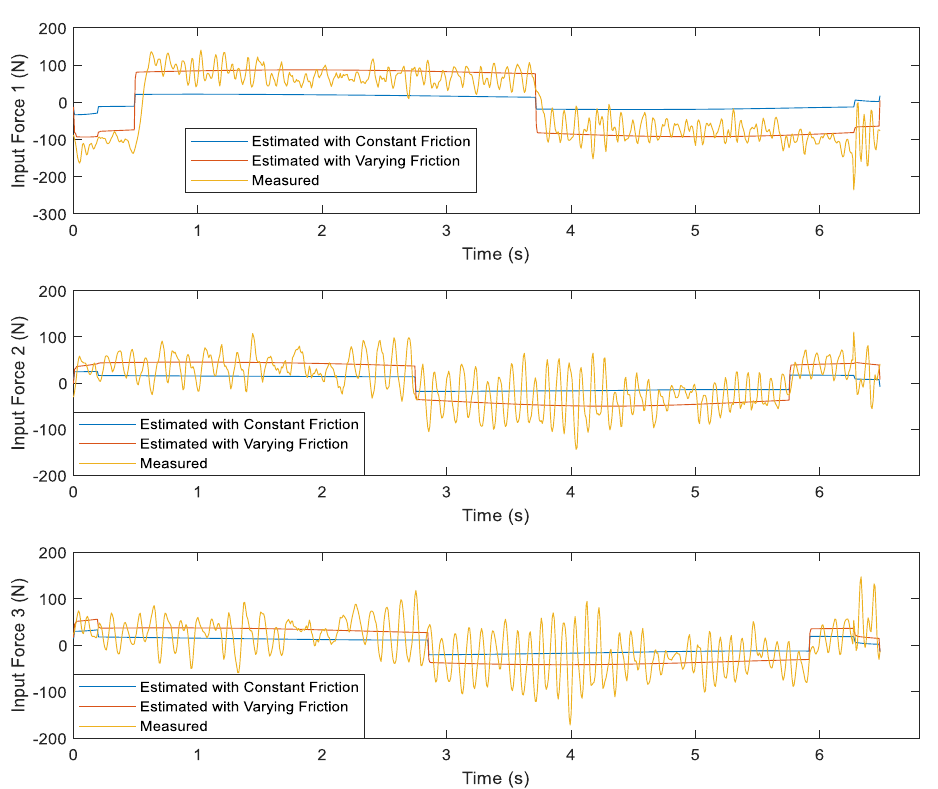
Figure 14. Full-circle validation trajectory.